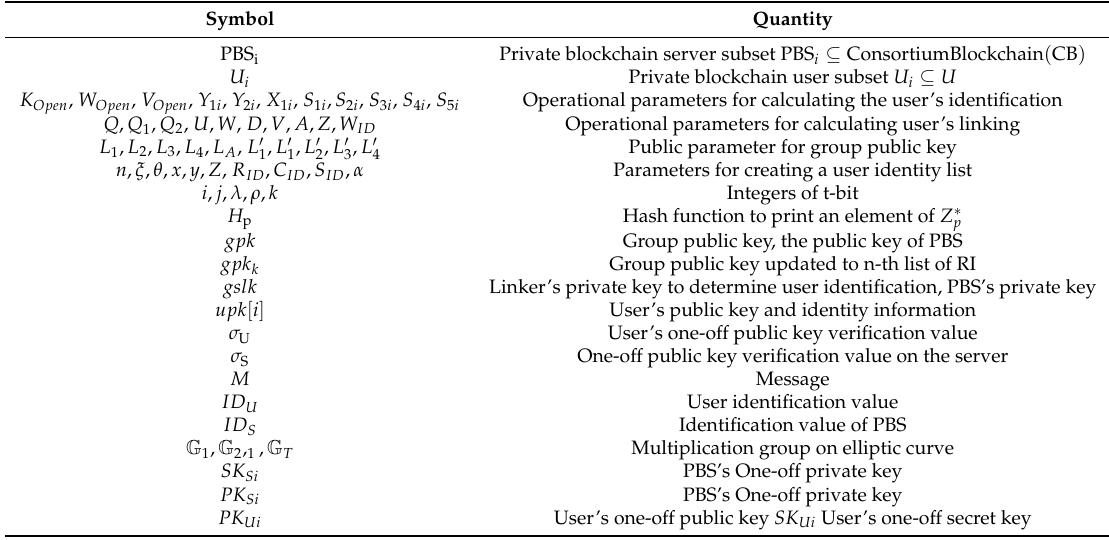
Table 5. System parameters for the proposed